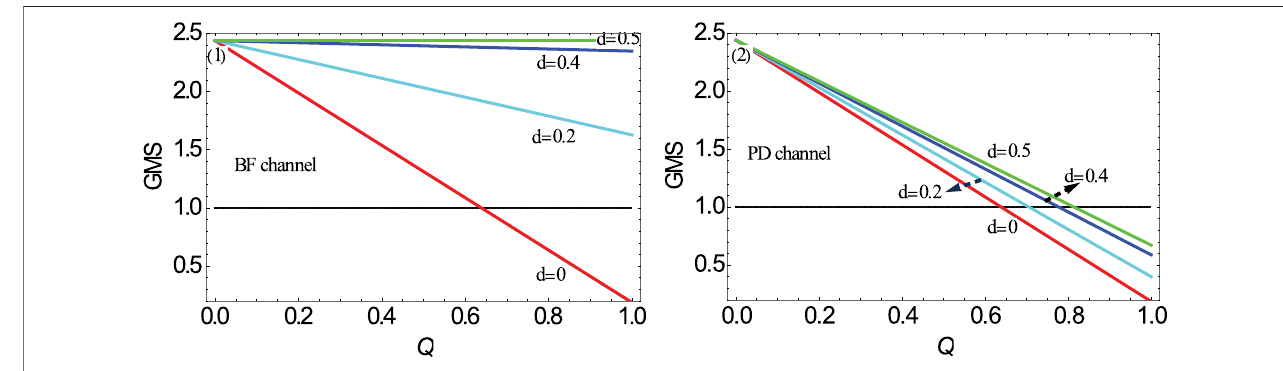
(cid:8)(cid:8) √ 2 /2 in the different noisy